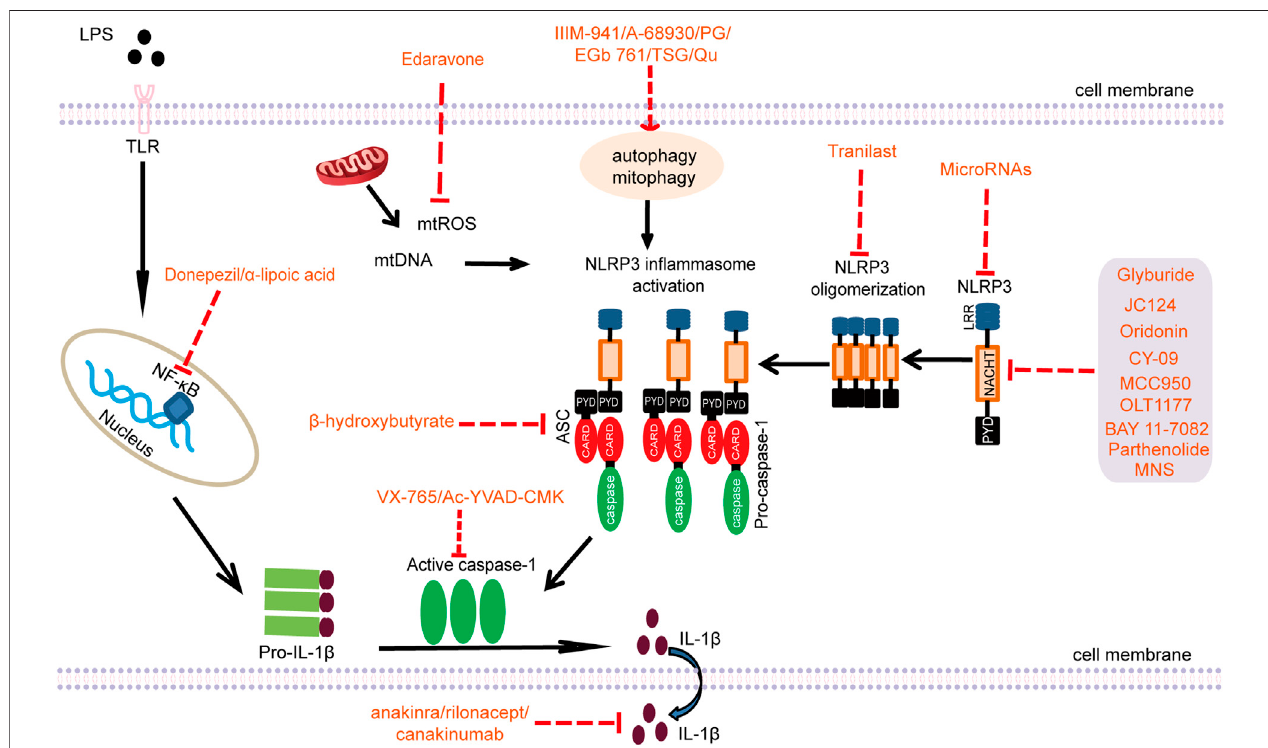
FIGURE 2 | Pharmacological targets of the NLRP3 in fl ammasome (LPS: lipopolysaccharide; TLR: Toll-like receptor; NF- κ B: nuclear factor kappa B; mtROS: mitochondrial ROS; mtDNA: mitochondrial DNA; NLRP3: nucleotide-binding oligomerization domain-like receptor pyrin domain-containing 3; ASC: apoptosis- associated speck-like protein containing a CARD; PG: progesterone; TSG: 2,3,5,4 ′ -Tetrahydroxystilbene-2-O- β -D-glucoside; Qu: Quercetin; MNS: 3,4- methylenedioxy- β -nitrostyrene; CARD: caspase recruitment domain; NACHT: nucleotide-binding and oligomerization domain; PYD: pyrin domain; LRR: leucine- rich